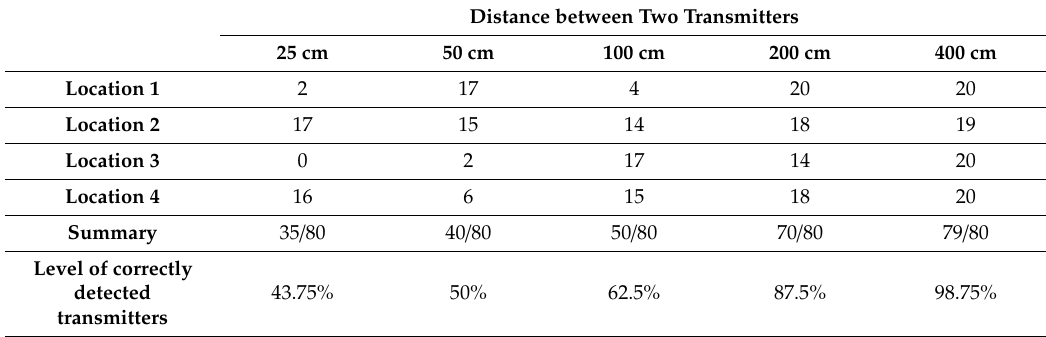
Table 3. Number of correct transmitters detected in relation to the distance between two transmitters and the location of the receiver.